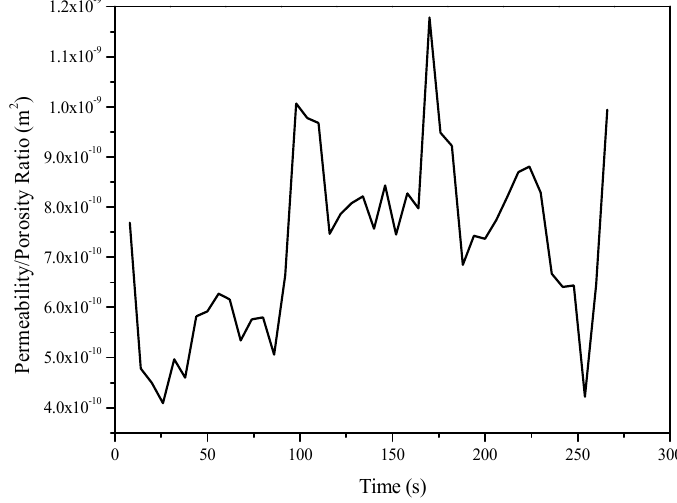
Figure 10. Local permeability/porosity ratio of the preform used in the experiment shown in Figure 9.